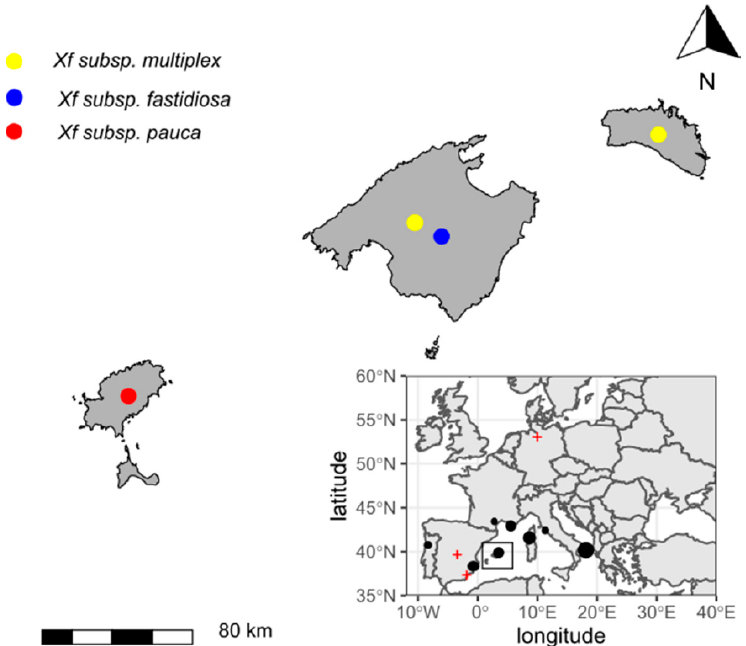
Figure 2. Distribution of Xf in the Balearic Islands and Europe. Outbreaks considered eradicated are marked with a red +. All areas where Xf is well established (black dots) are less than 50 km from the coast. Size of circles is proportional to the area affected by the